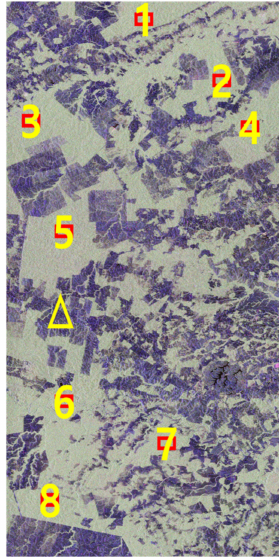
Figure 6. Pauli RGB (R = | HH − VV | , G = | HV | , B = | HH + VV | ) image of the ALOS PALSAR data acquired around the Amazonian forest near Rio Branco, Brazil on 20 July